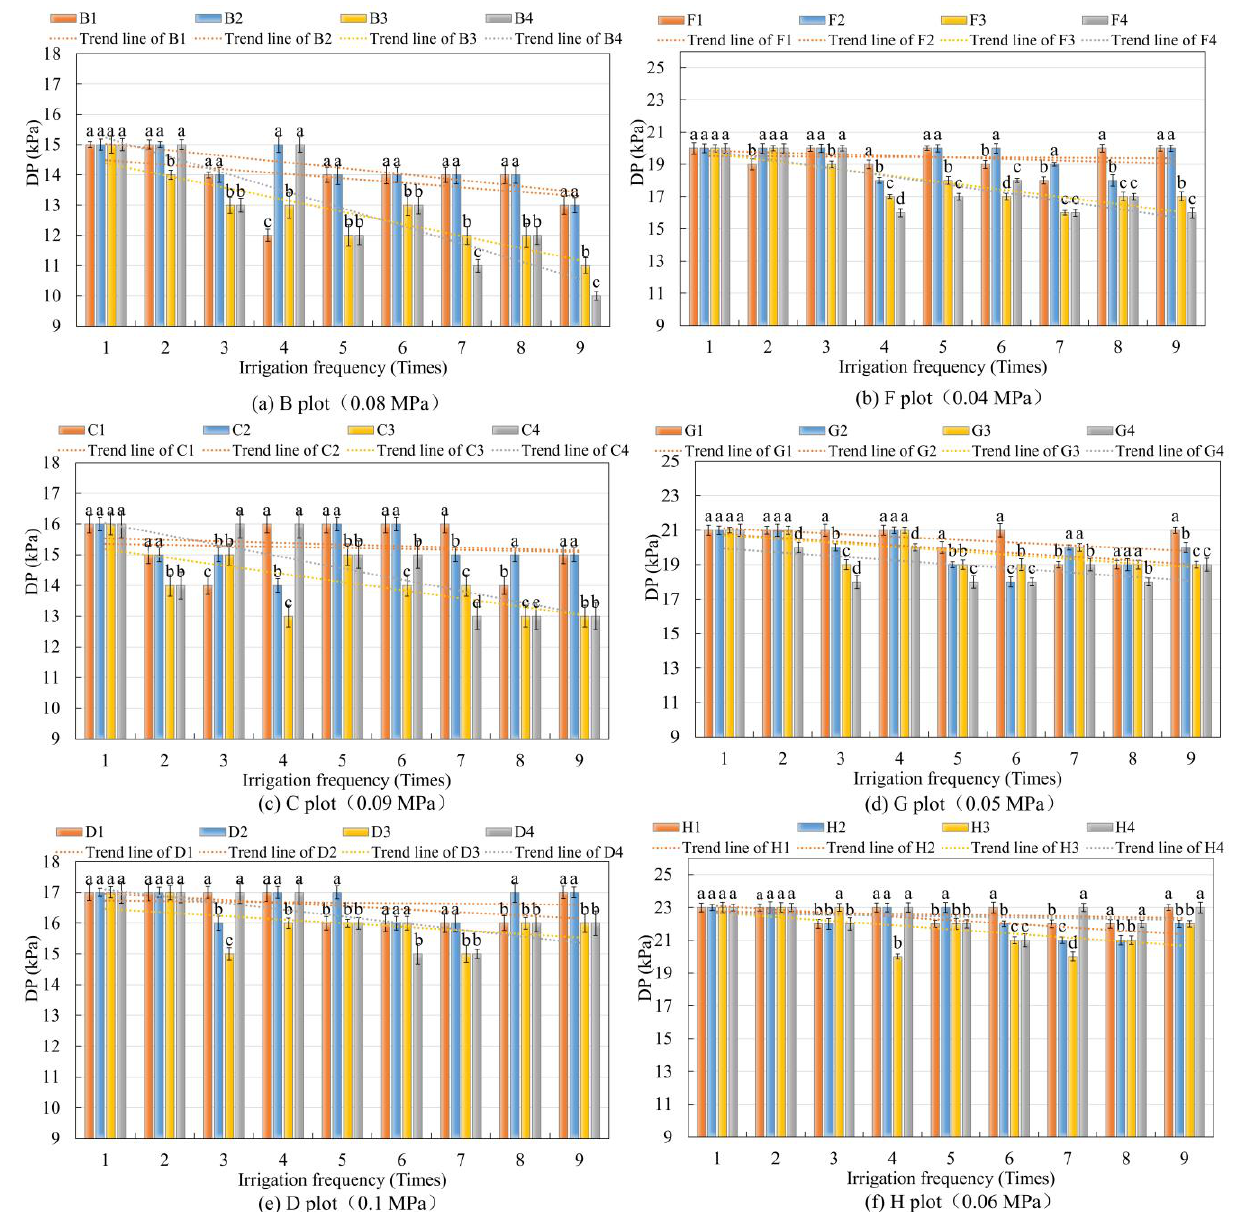
Figure 3. Changes of differential pressure with irrigation frequency. Note: DP is the differential pressure; irrigation frequency refers to the number of irrigations that were carried out; the values were the mean of the 95% confidence interval; and the different letters in the same group indicate significant differences ( p < 0.05). B, C, D, F, G, H represent different experimental plots. The 1, 2, 3, and 4 after the same letter represent the working conditions of the same type of driplines matched with different filters at the same pressure, respectively. The 1, 2, 3, and 4 represent the working conditions with the disc filter with aperture of 125 μm, the screen filter with aperture of 125 μm , the screen filter with aperture of 200 μm and no filter, respectively.